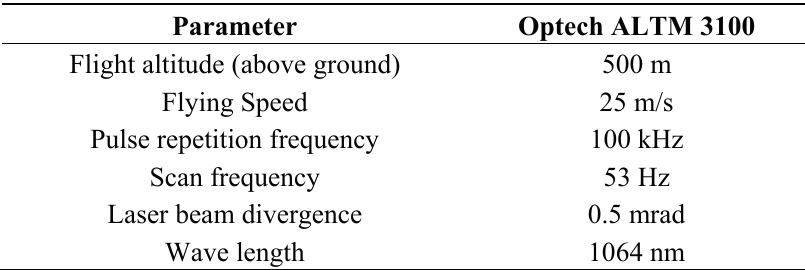
Table 2. Airborne Lidar